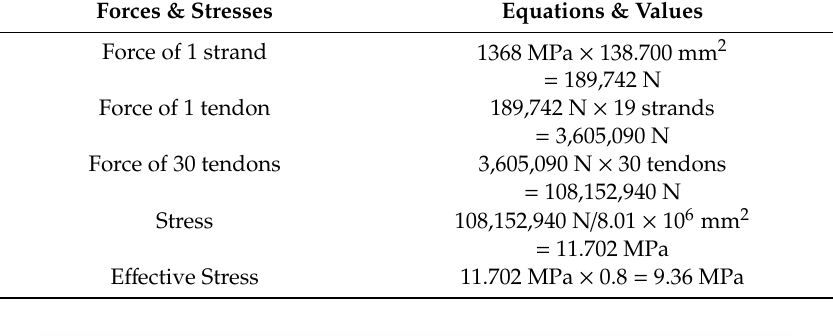
Table 10. Prestressing force.